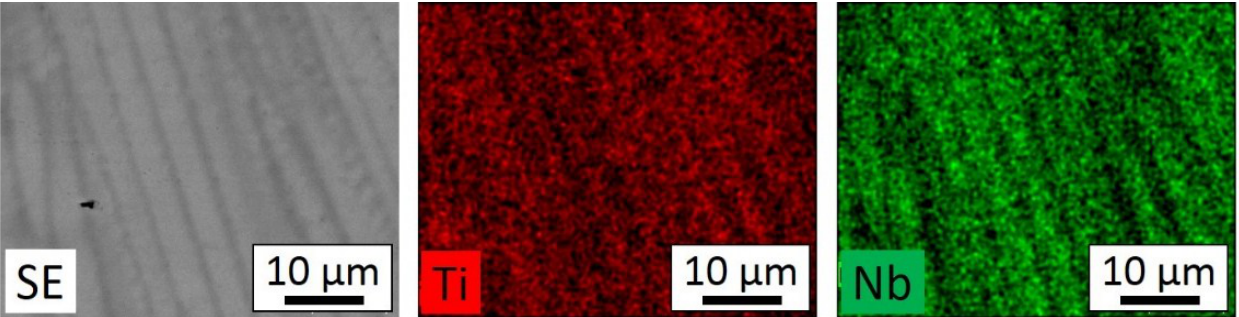
Figure 4. Energy dispersive X-ray spectrometer (EDX) mapping of the elliptical-shaped grains and their segregation edges for samples obtained with the SLM parameters: laser speed, 35 mm/s and laser power, 250 W (etchant: Kroll’s agent, 11